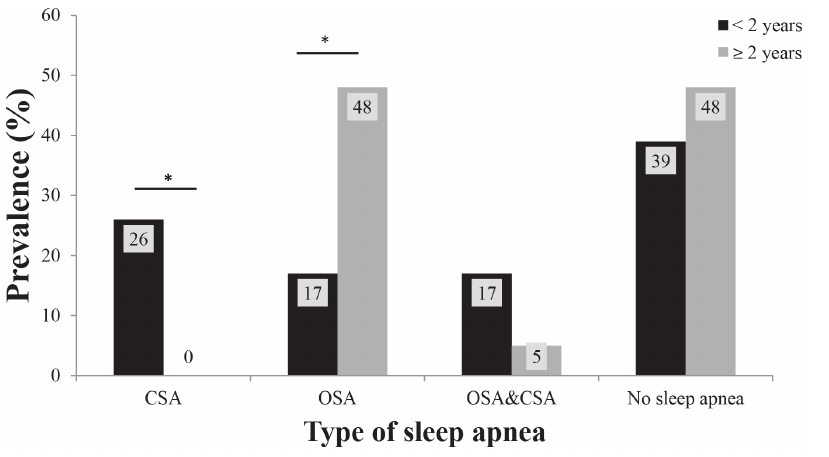
Figure 1. Prevalence of sleep apnea stratified by age group. Below the figure: CSA- central sleep apnea; OSA- obstructive sleep apnea; *- p , 0.05.